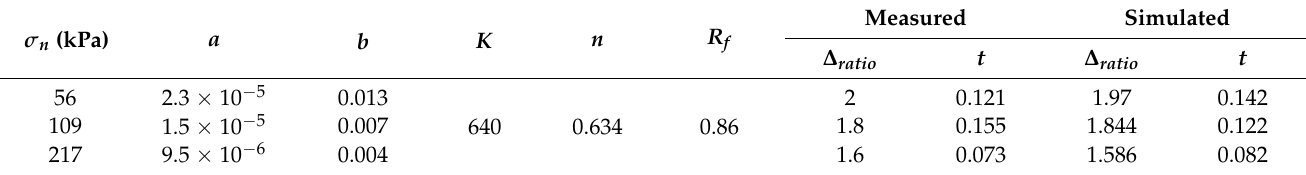
Table 2. Input parameters used for simulating stress-displacement curves reported by Hsu (2017).